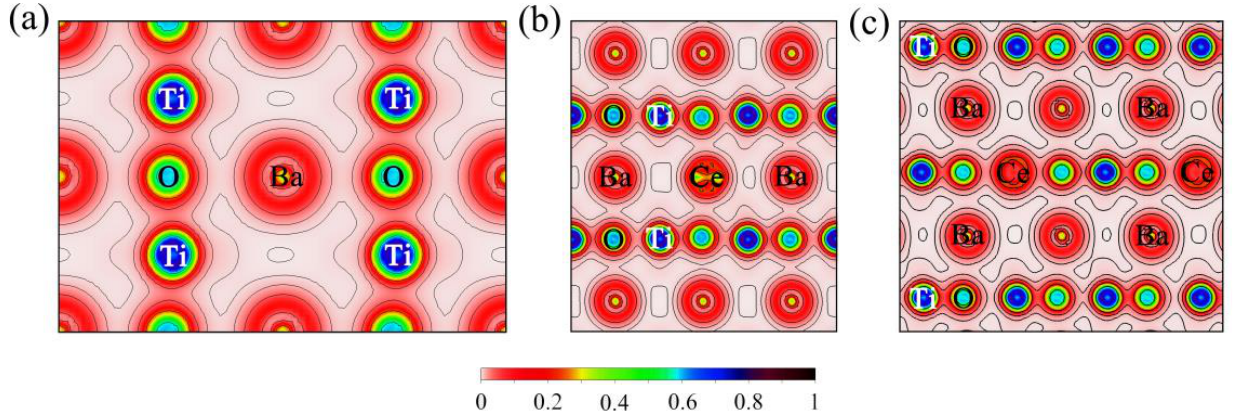
Figure 4. C harge density maps in the (0 0 1) plane for ( a ) pristine BaTiO 3 , ( b ) Ba site substitution, and ( c ) Ti site substitution.